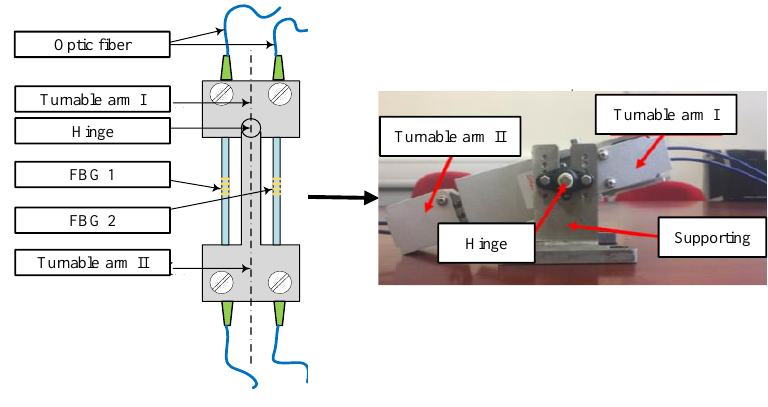
Figure 2. FBG bending gauge sensor.